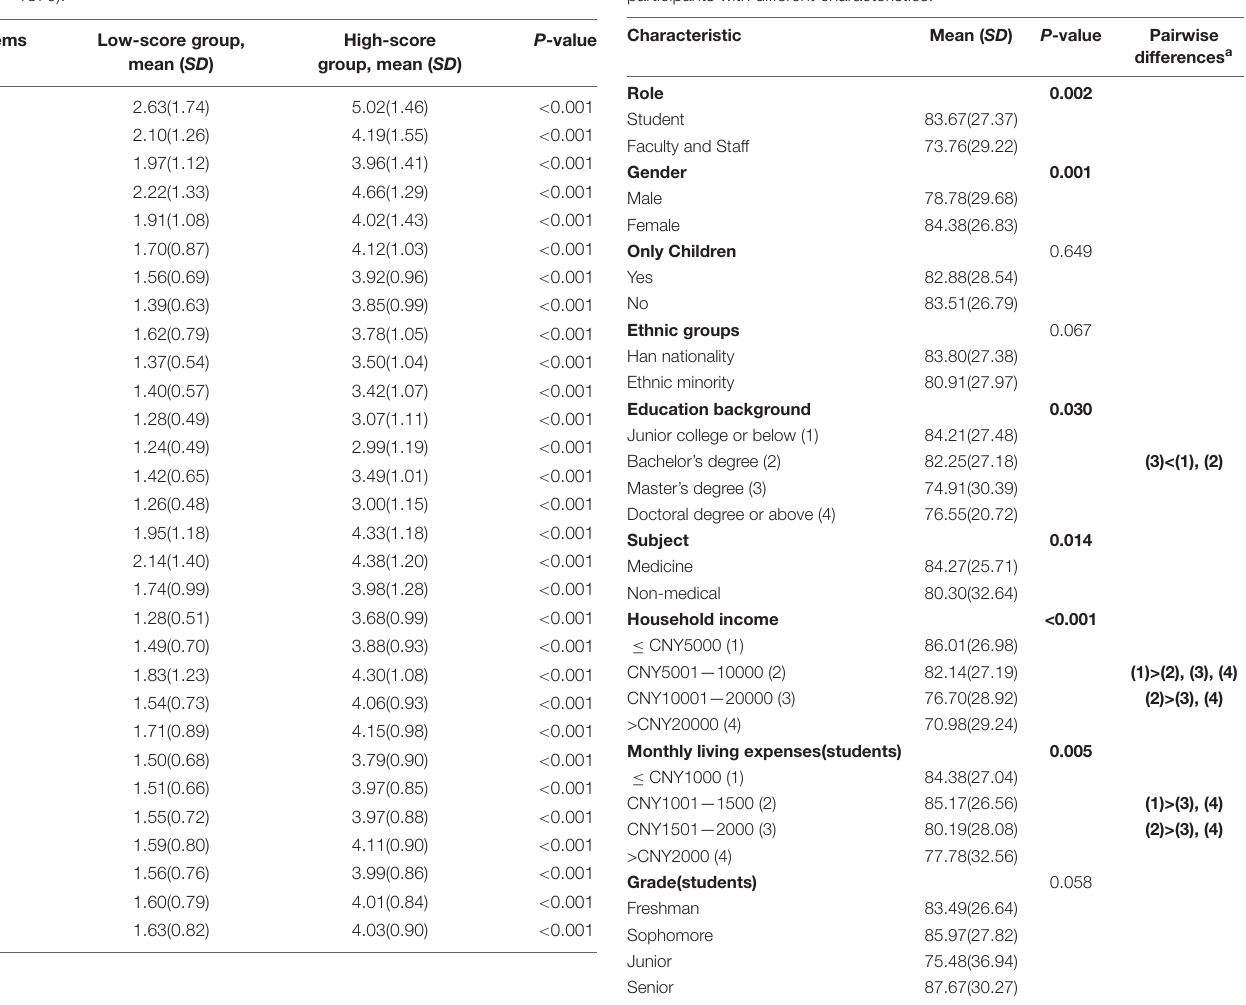
TABLE 10 | Comparison of the Chinese Revision of the Pitt Wellness Scale of participants with different